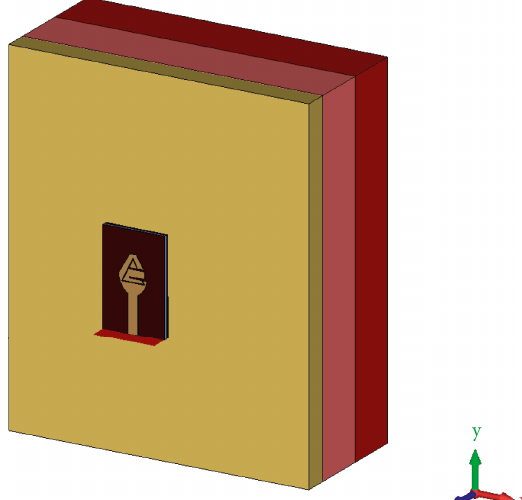
Figure 35: On-Body simulation setup for a single-element antenna.